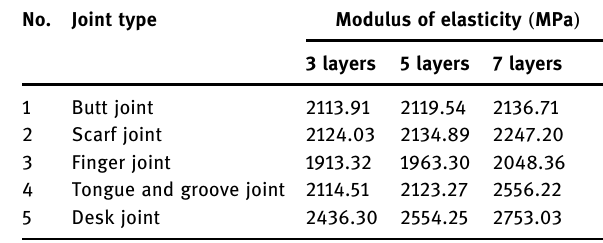
Table 5: Tensile strain of di ff erent joint types No.